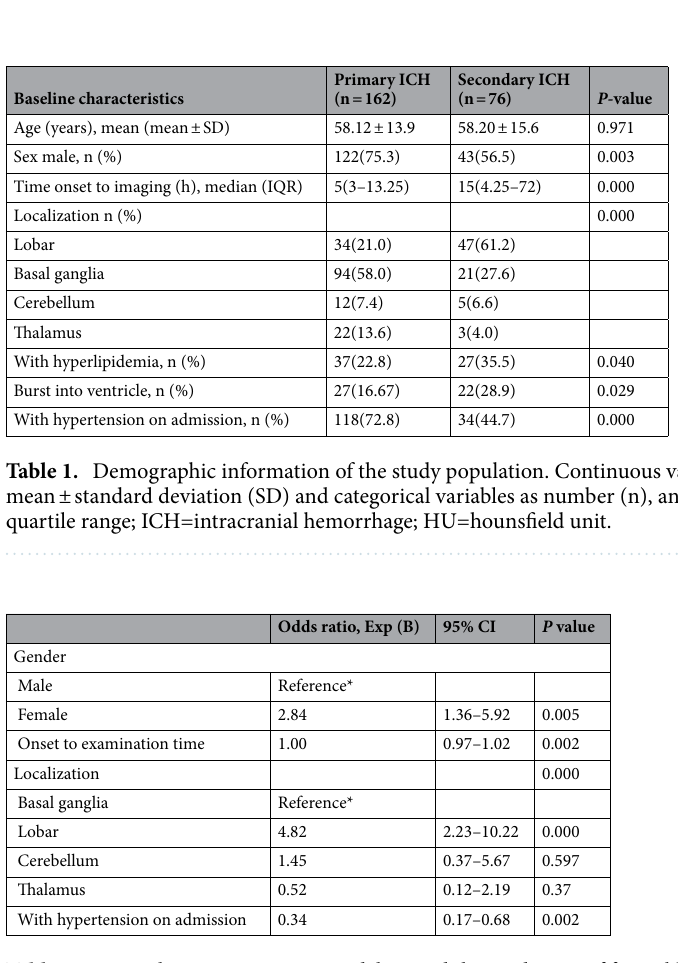
Table 2. Binary logistic regression modeling and the prediction of favorable outcome. Binary analysis was used with a stepwise forward selection. All selected variables are presented with OR, 95%CI, and P value. *Reference point for other OR